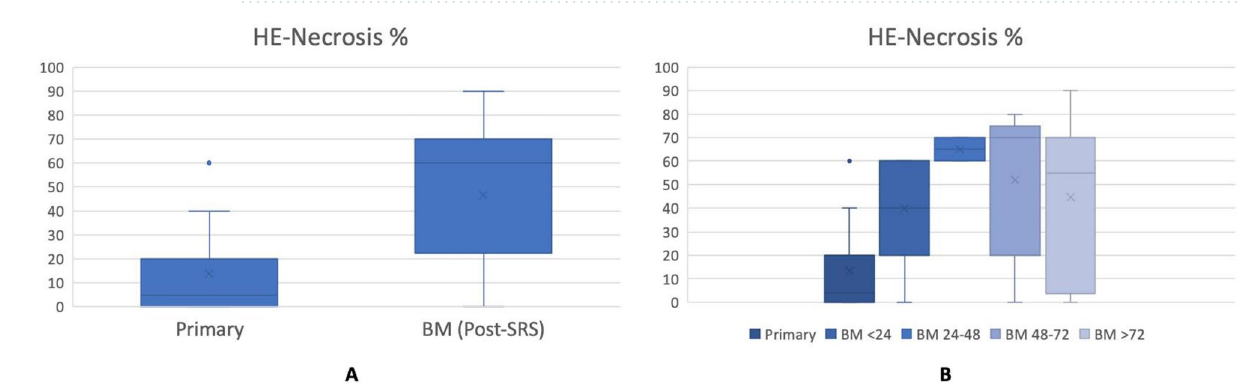
Figure 2. Relationship for the percentage of tumor necrosis between the primary tumor and irradiated BM: ( A ) tumor necrosis in primary tumors was significantly lower than irradiated BM; ( B ) no difference in the proportion of tumor necrosis with respect to time interval from SRT to surgery was observed: primary (non- irradiated), BM < 24 h, 24–48 h, 48–72 h and > 72